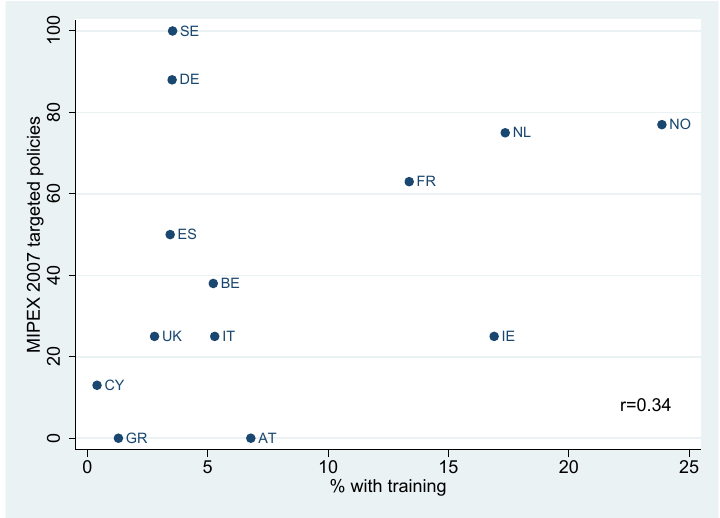
Figure 3: Proportion of third-country immigrants who participated in training and countries’ MIPEX of labor market mobility, access to targeted support.